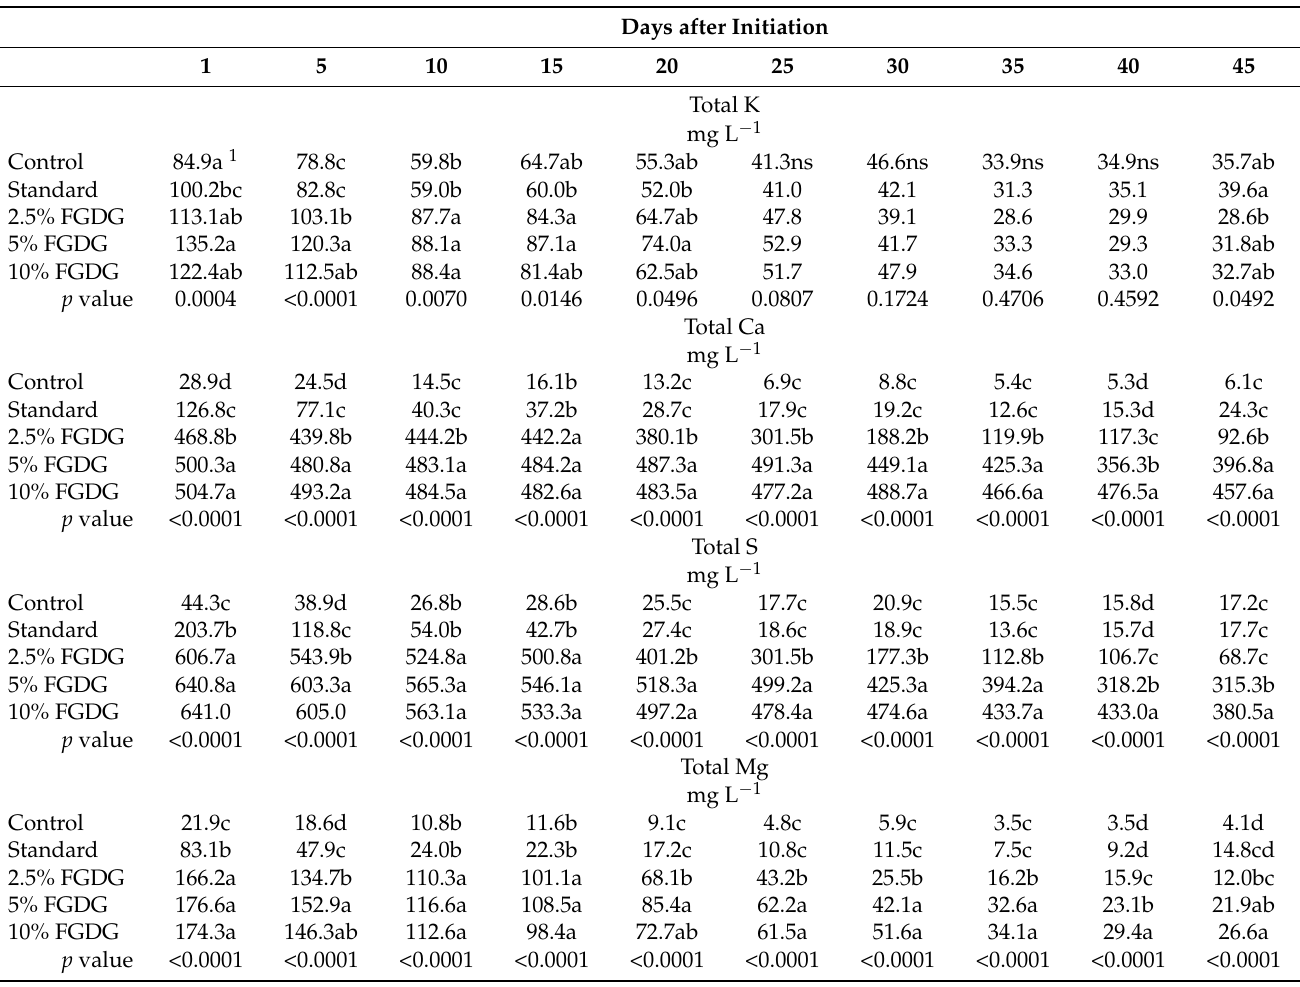
Table 2. Effect of substrate amendments on K, Ca, S, Mg over time in leachate of daily irrigated pine bark columns from the 2022 experimental run. Substrate treatments consisted of neither dolomitic limestone nor FGD gypsum (Control), 4.15 kg m − 3 dolomitic limestone (Standard), dolomitic